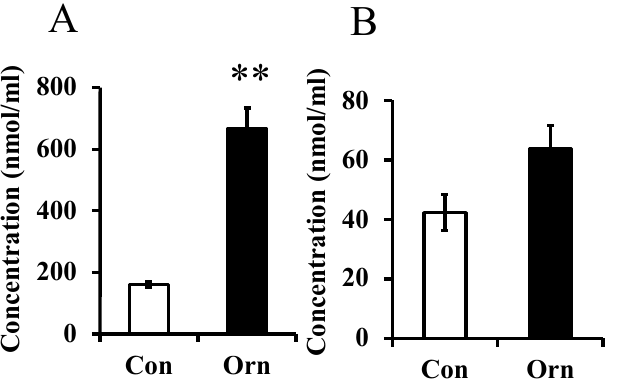
Figure 1. Concentration of L-ornithine in mother plasma at P21 ( A ) and in milk at P9 ( B ) in Experiment 1. Data are expressed as means ± SEM. n = 6–8/group. ** p < 0.01. Con: control, Orn: ornithine.